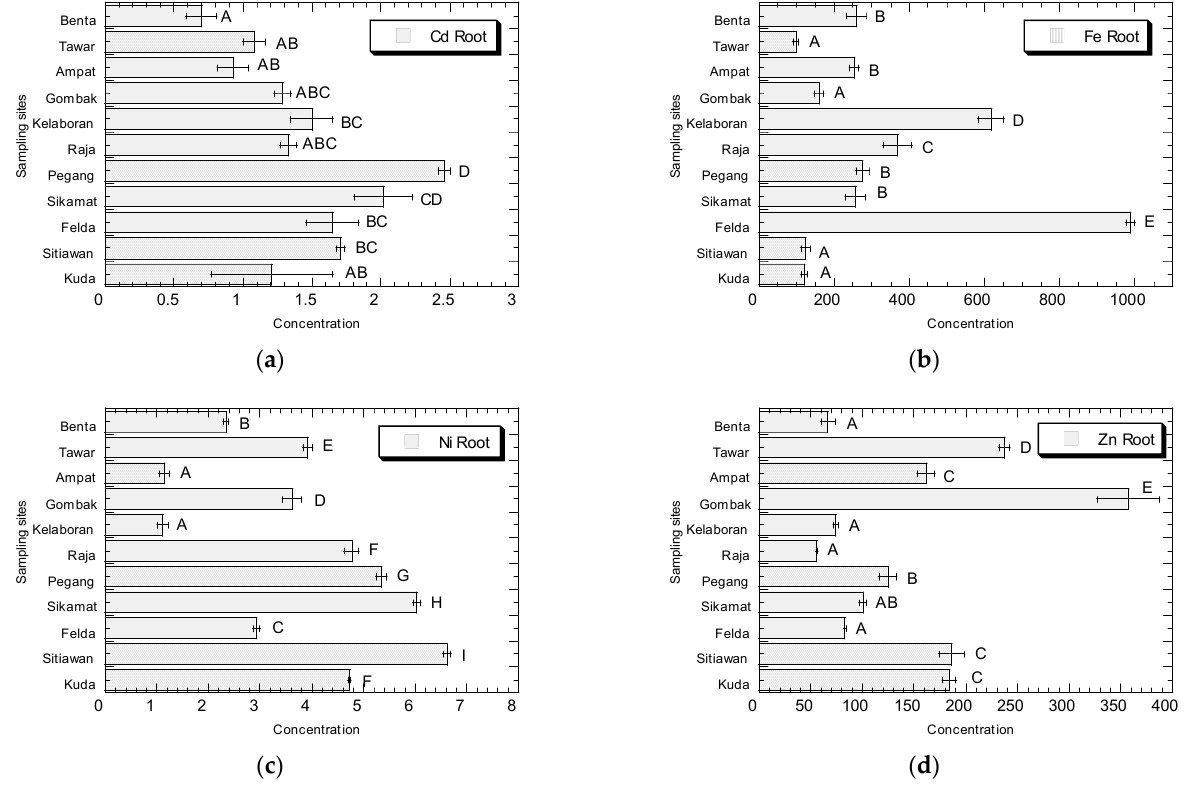
Figure 4. Concentrations (mean ± SE, µg/g dry weight) of Cd ( a ), Fe ( b ), Ni ( c ), and Zn ( d ) in the roots of Amaranthus viridis collected from all the sampling sites in Peninsular Malaysia. Metal concentrations sharing a common letter are not significantly different ( p > 0.05) based on the post-hoc test (Student–Newman–Keuls) in the one-way ANOVA analysis.